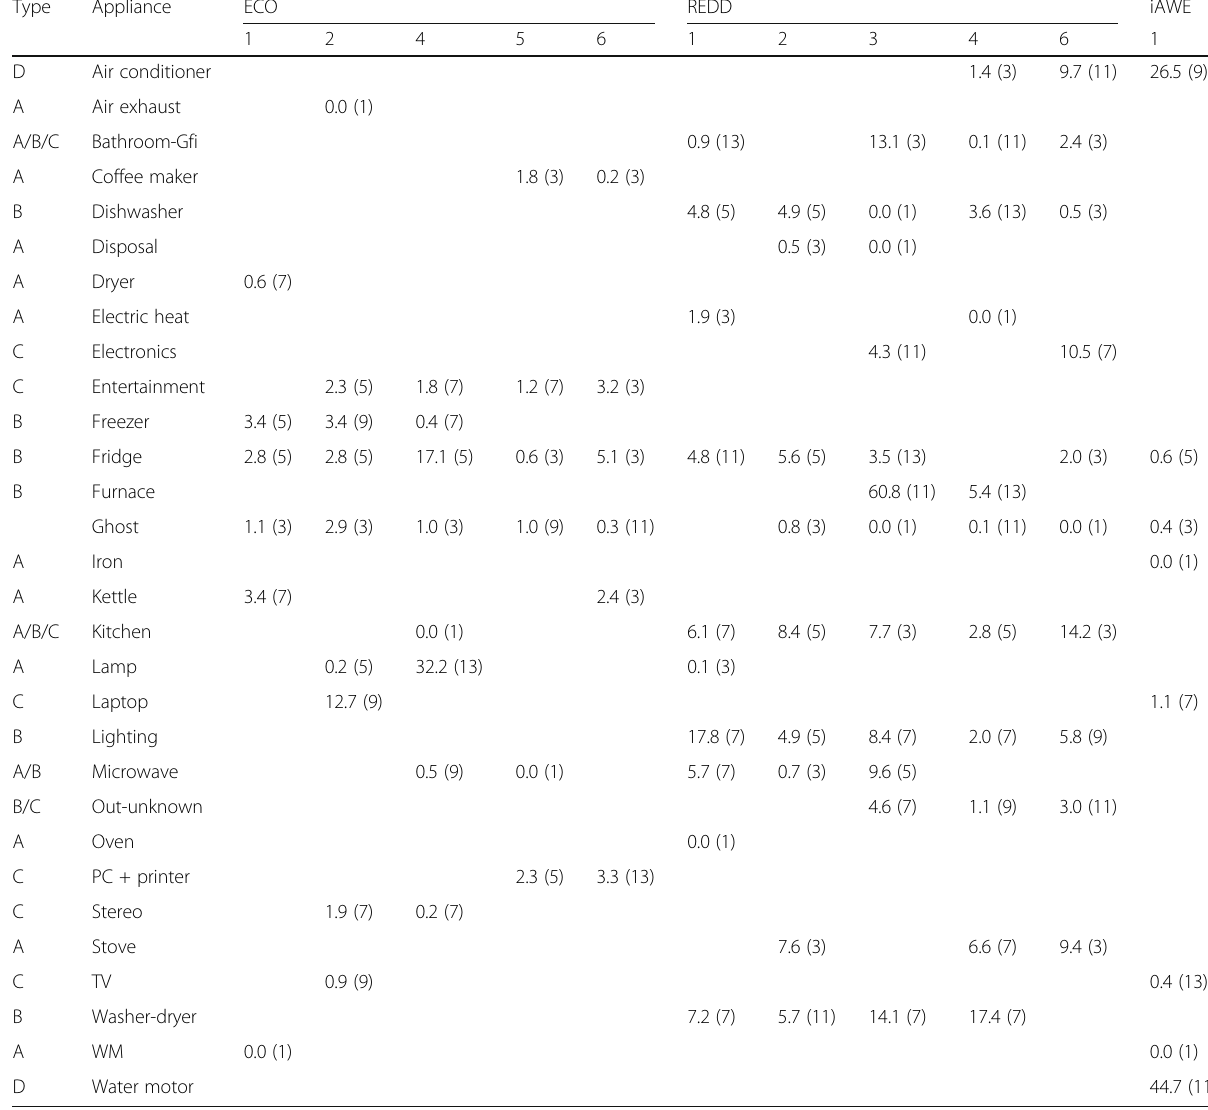
when using the optimal ACC